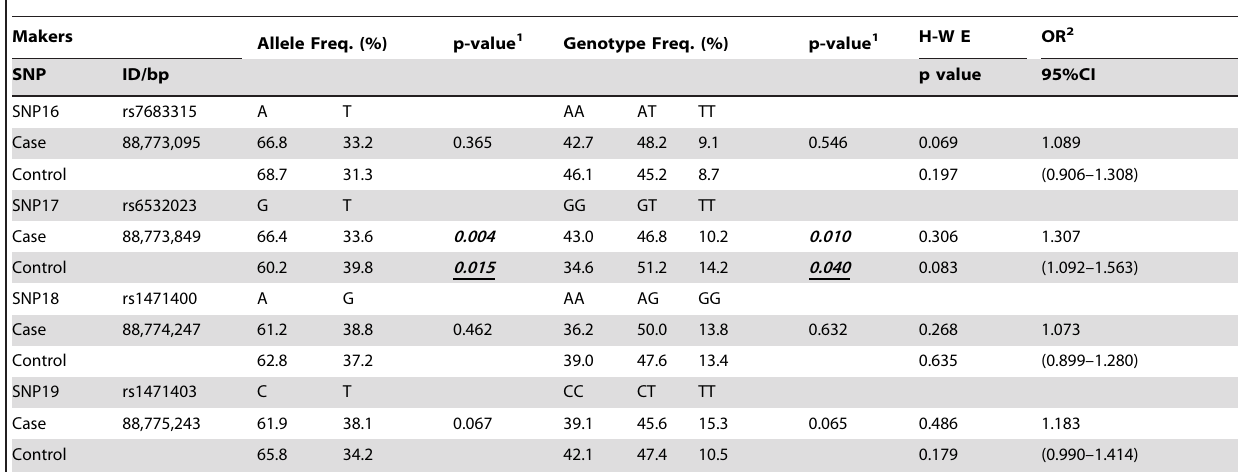
Table 2. Allele and genotype frequency of single SNP association analysis.